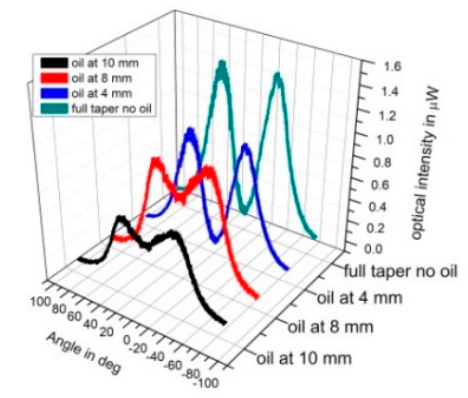
Figure 11. Angular optical intensities for a taper with index matching oil gradually covering the conical section.